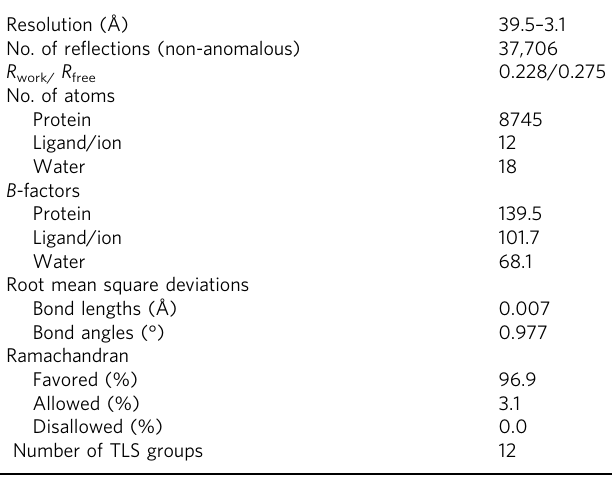
Table 3 Re fi nement statistics for full-length MthK.